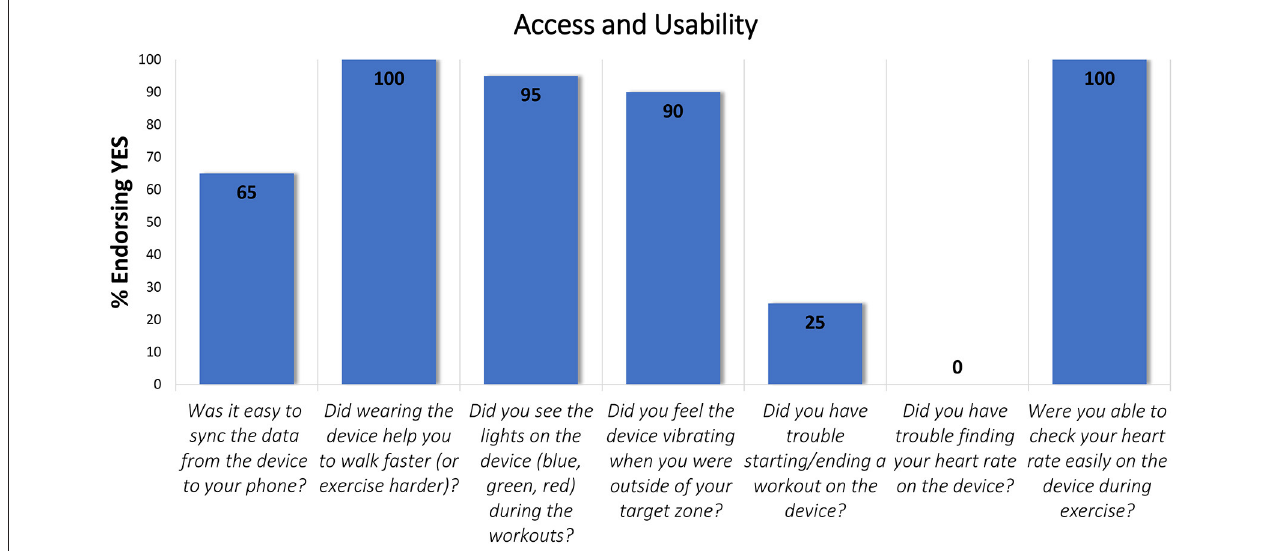
FIGURE 2 | Exit Survey items that aligned with the Access and Usability